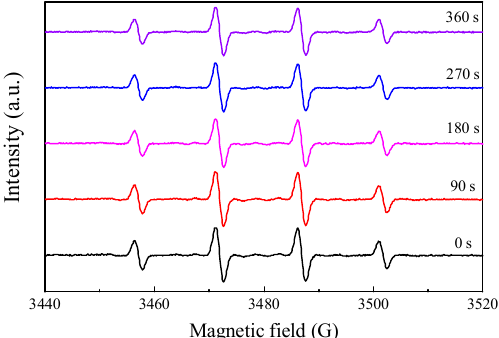
Figure 4. Electron spin resonance (ESR) signals of the 5, 5-dimethyl-1-pyrroline N -oxide (DMPO)- • OH adducts in aqueous solution under visible light irradiation in the system of pyrite and CYN. DMPO concentration = 0.04 mol/L; pyrite dose = 0.5 g/L.